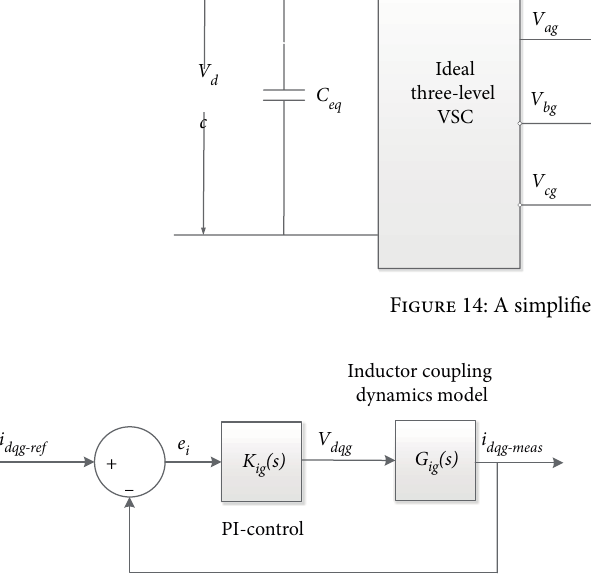
Figure 15: The control structure for the GSC current control (inner